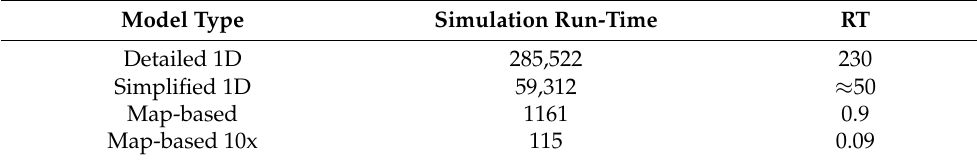
Table 5. Real-Time factors of the proposed engine models.